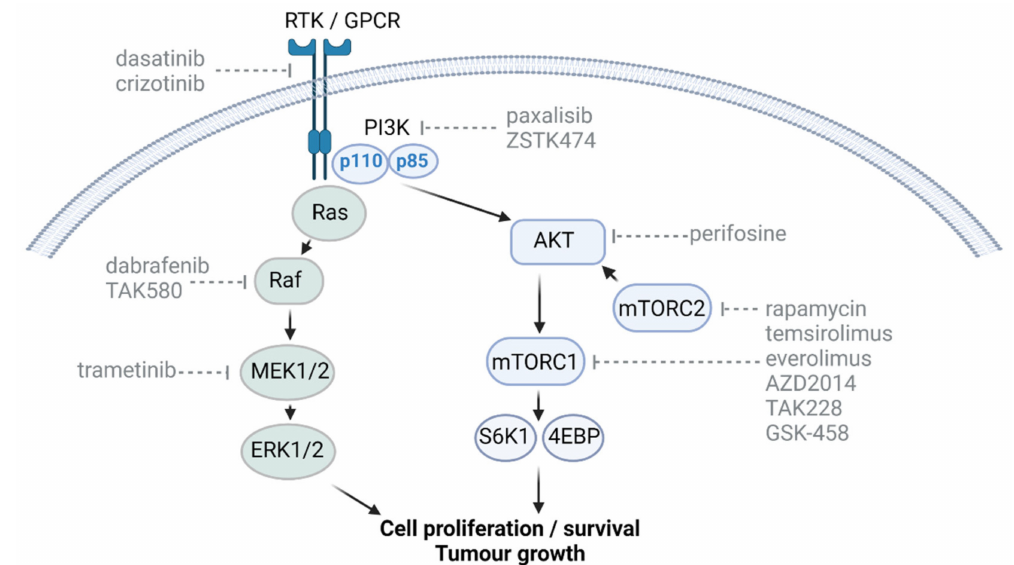
Figure 1. Therapeutic targets of RTK activation and PI3K/AKT/mTOR signalling pathways in DMG. Receptor tyrosine kinases (RTK) and/or G-protein-coupled receptors (GPCRs) are activated by a variety of growth factors, neurotransmitters and hormones, including insulin, brain-derived neurotropic factor, glutamate and cannabinoids (reviewed in [102]). Receptor activation recruits the intracellular association of the phosphatidylinositol 3-kinase (PI3K) regulatory (p85) and catalytic (p110) subunits. The subsequent engagement of Ras results in the activation of the Raf–mitogen-activated protein kinase kinase (MEK)–extracellular signal-regulated kinase (ERK) 1/2 pathway. Alternately, RTK-induced PI3K activation promotes AKT signalling involving the mechanistic target of the rapamycin (mTORC1/2) pathway. The triggering of these pathways initiates a variety of signals that promote DMG tumour cell proliferation, survival and tumour growth. A range of inhibitory compounds, shown in grey with dotted lines indicating specific mechanistic targets, have been tested within the setting of